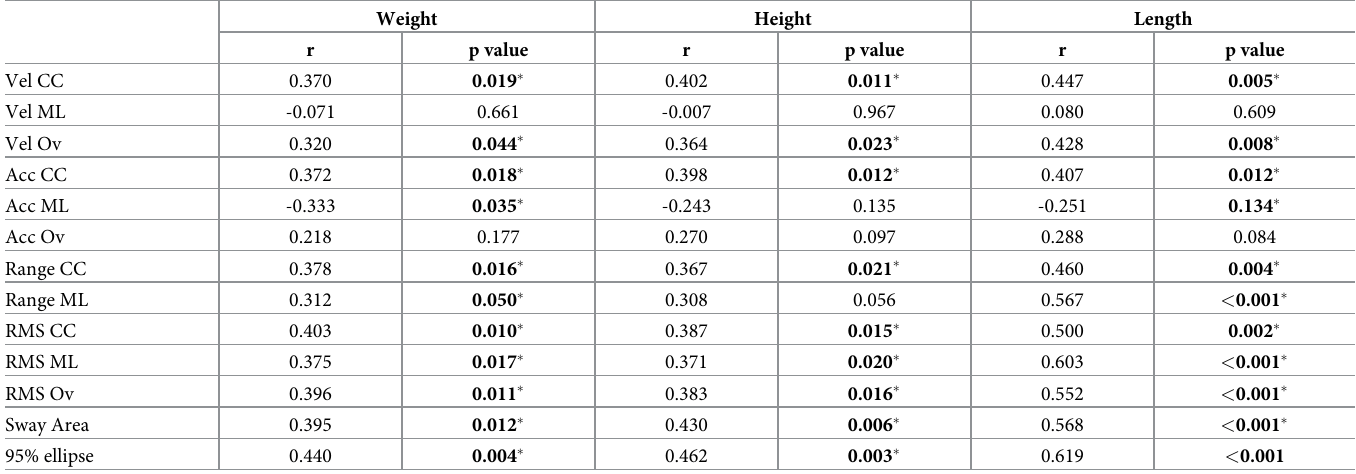
Table 2. Correlation between morphometric variables and postural sway in younger dogs.